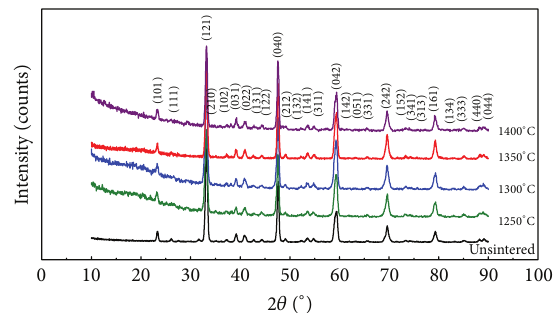
Figure 2: XRD patterns of CaTiO 3 ceramics fabricated under differ- ent sintering conditions, with respect to unsintered ones, 1250 ∘ C, 1300 ∘ C, 1350 ∘ C, and 1400 ∘ C,